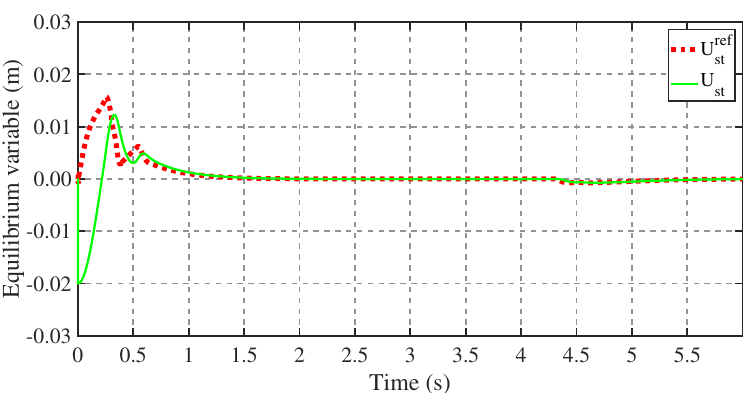
Figure 16. Trajectory of the equilibrium variable when the robot is sliding.